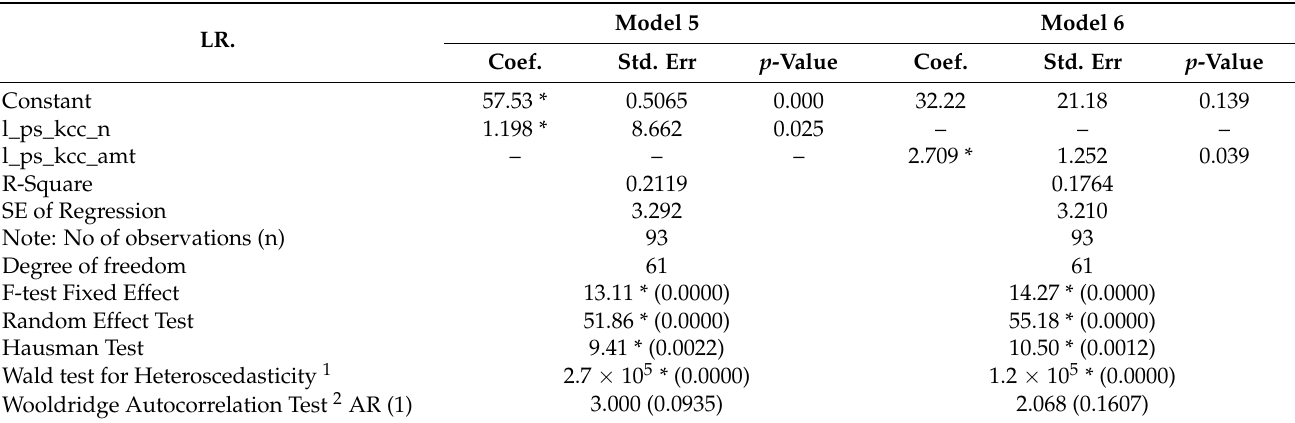
Table 6. Result of Regression Analysis (Static Panel Data